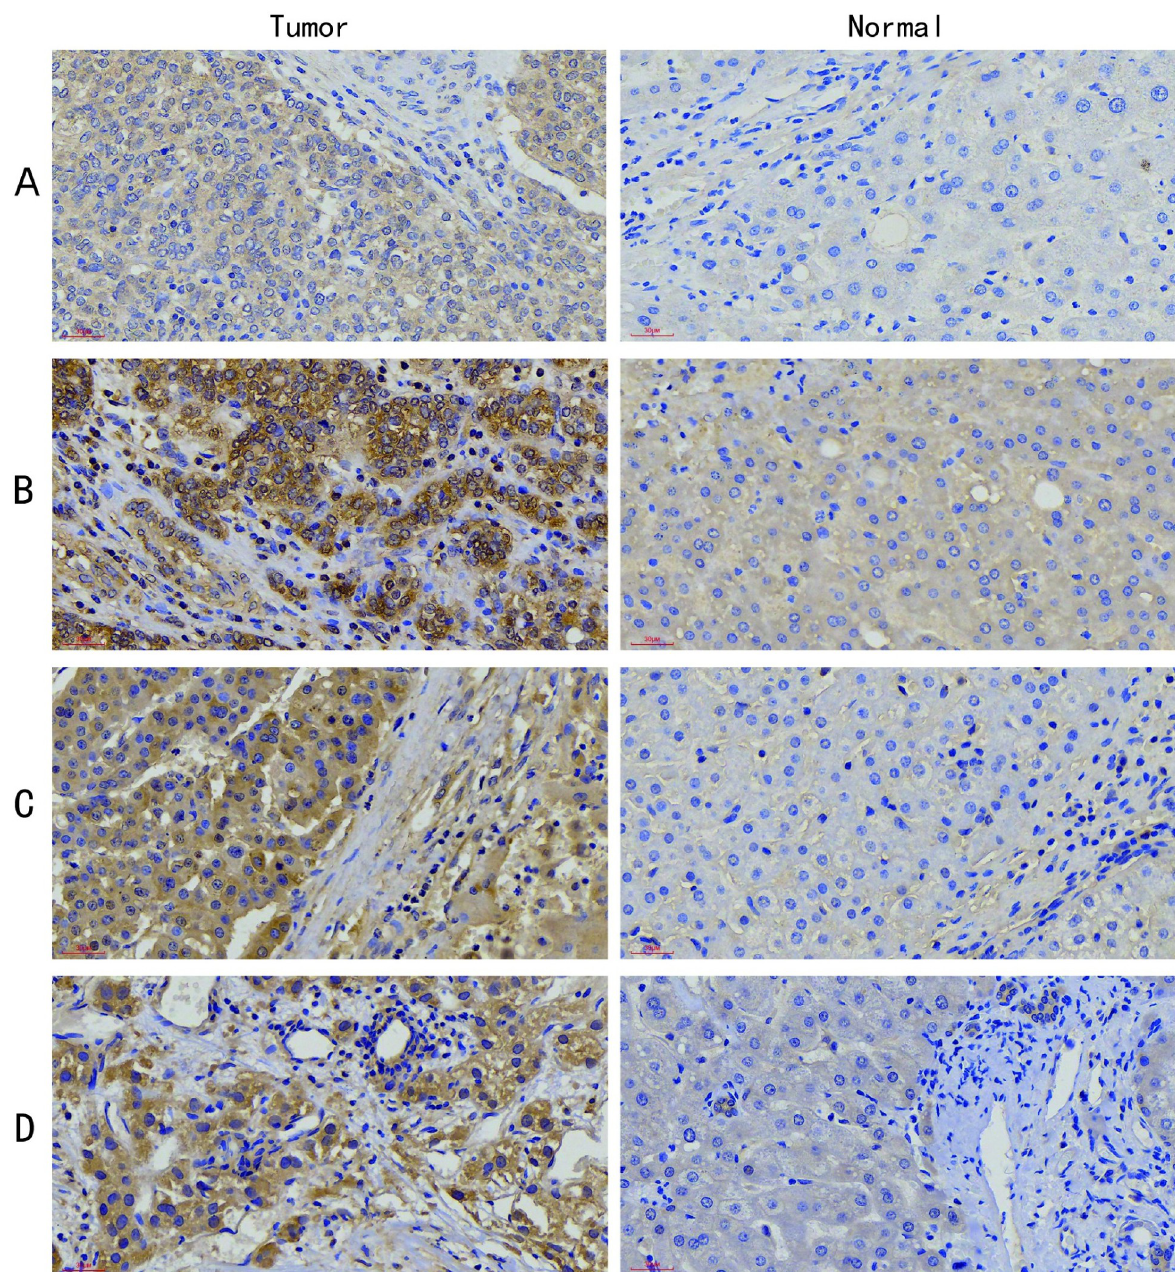
Fig 7. Representative images of immunostaining for HSP90AA1, PPIA, SQSTM1, and USP21 in liver tumor tissues and normal liver tissues. (A) Immunohistochemical analysis of HSP90AA1 expression, original magnification × 40. (B) Immunohistochemical analysis of PPIA expression, original magnification × 40. (C) Immunohistochemical analysis of SQSTM1 expression, original magnification × 40. (D) Immunohistochemical analysis of USP21 expression, original magnification × 40.